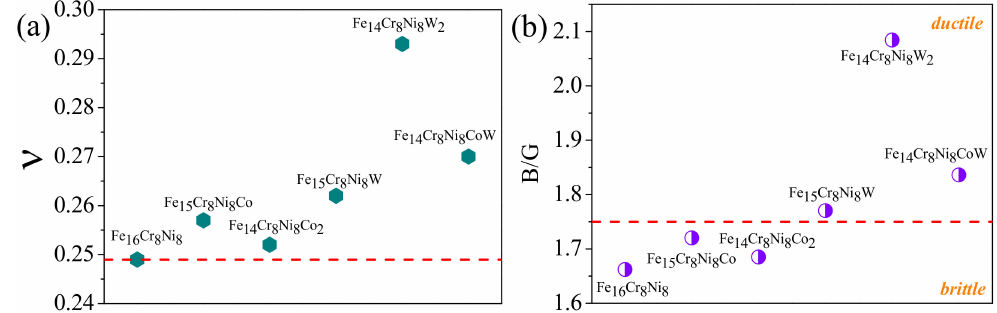
Figure 7. Calculated Poisson’s ratio and B / G values of di ff erent systems: ( a ) Poisson’s ratio and ( b ) B / G .